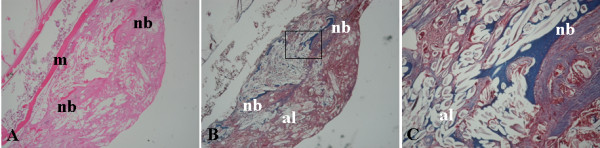
The histological sections of the graft in the animals implanted with Alginate-MSCs composite. A. H&E stains showed new bone formation was present in the graft fragments and there was no evidence of inflammatory cells or reactions to the alginate carrier (original magnification ×4). B, C. Masson trichrome stains showed new trabecular bone with collagen-fibril formation (blue areas) in the graft (B, original magnification ×4; C, original magnification ×10). m = muscle; nb = new bone; al = alginate remnants.